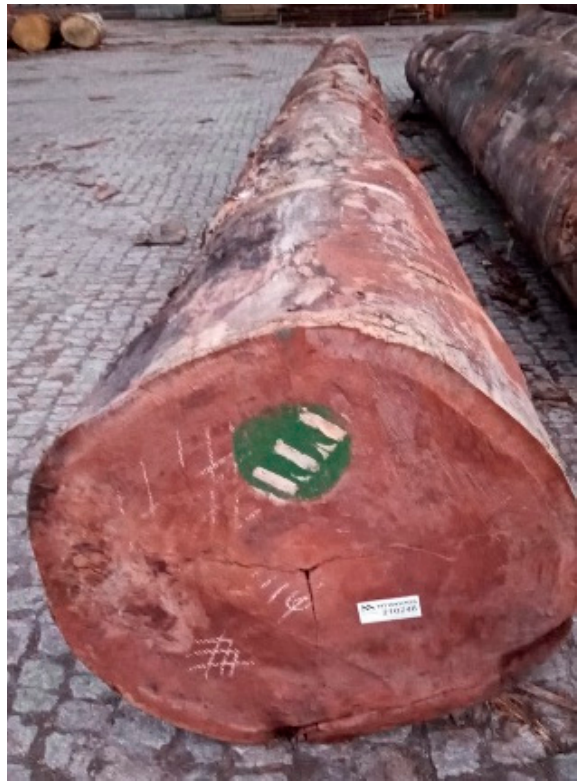
Figure 1. Iroko ( Milicia excelsa ) log.